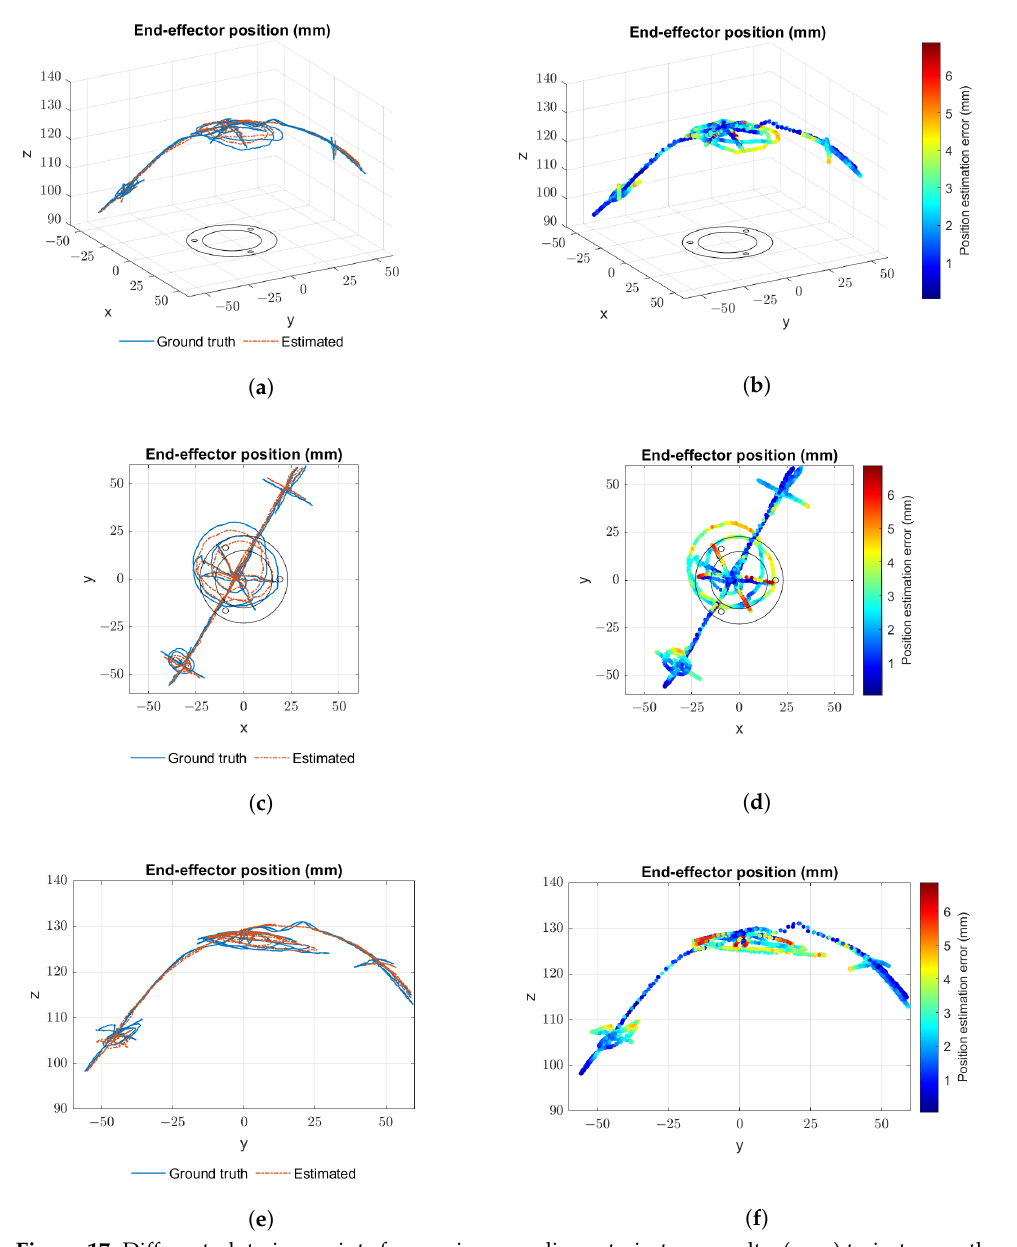
Figure 17. Different plot view points for passive compliance trajectory results: ( a , c , e ) trajectory paths as perceived by the proprioceptive system (orange) and by the Polaris system (blue); ( b , d , f ) colour scale plot of the error between proprioceptive system readings and the